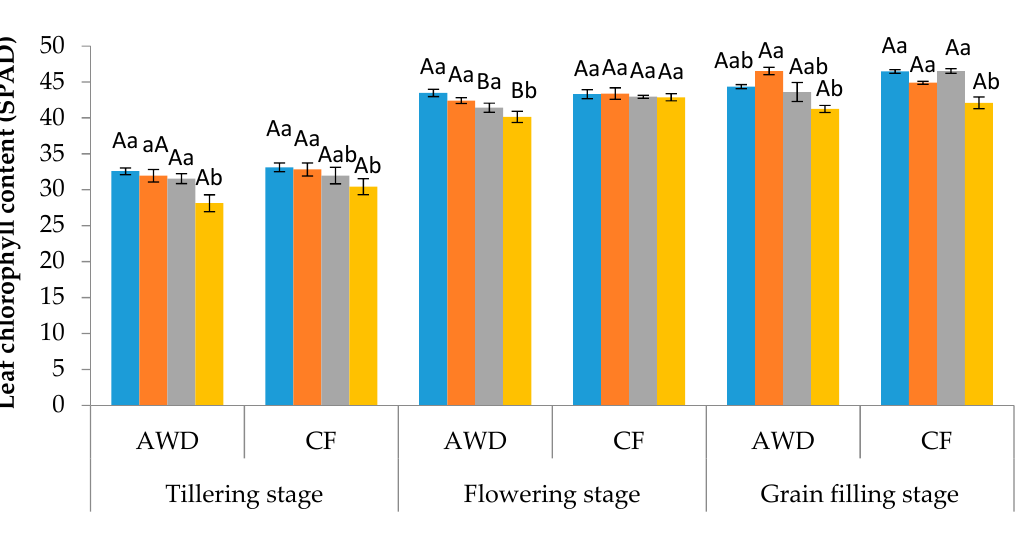
Figure 2. Effects of irrigation regimes and organic amendments on leaf chlorophyll content at major growth stages of rice. Notes: Different means with capital and small letters show a significant variation between irrigation practice and organic amendment. When two irrigation practices with the same organic amendment treatment exhibit the same capital letter, the means are not significantly different ( p < 0.05). The means of various organic amendments are not statistically different under the same irrigation practice when followed by the same small letter ( p < 0.05), based on the Tukey’s test analysis. AWD, alternate wetting and drying; CF, continuous flooding; RHB, rice husk biochar, EFBB, oil palm empty fruit bunch biochar; control, no organic amendments.